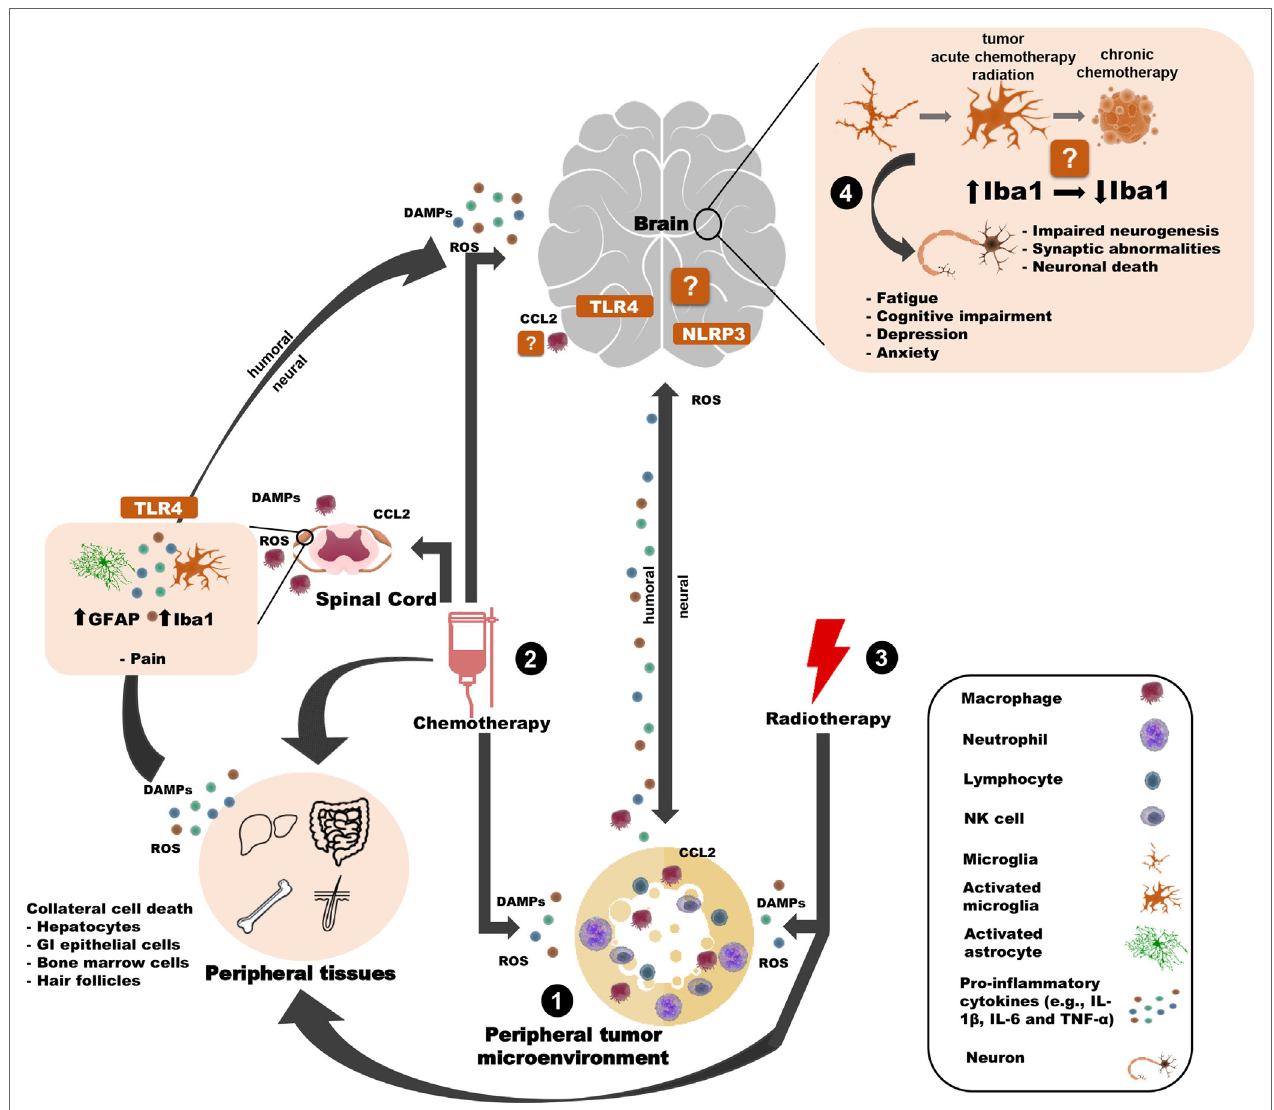
FiGURe 1 | Potential innate immune mechanisms by which peripheral cancer and cancer treatments can induce behavioral changes. (1) The tumor microenvironment releases pro-inflammatory mediators (e.g, cytokines) that can influence the brain and behavior through humoral or neural routes. (2) Chemotherapy induces cell death of tumor cells and healthy cells (in the brain and the periphery), thereby causing the release of DAMPs, ROS, cytokines, and chemokines and contributing to many side effects. For example, chemotherapy-induced peripheral neuropathy is associated with astroglial and microglial activation in the spinal cord and TLR4 activation in DRG neurons. Similar inflammasome activity may occur in the brain. Chemotherapy may also weaken the blood–brain barrier, allowing peripheral immune cells to traffic into/closer to the brain. (3) Peripheral radiotherapy induces cell death of tumor cells and healthy “bystander” cells and (indirectly) contributes to microglial activation and behavioral deficits. (4) Together, the tumor and cancer treatments influence microglia. Tumors and radiotherapy (indirectly) activate microglia, whereas chemotherapy may affect microglia differently over time. Microglia interface with neurons to affect behavior, potentially through. Certain elements of this work were taken and then adapted from somersault18:24 (Library of Science & Medical Illustrations). To view their site, visit http://www.somersault1824.com/. They are licensed under the Creative Commons Attribution-NonCommercial-ShareAlike 4.0 International License. To view a copy of this license, visit http://creativecommons.org/licenses/by-nc-sa/4.0/ or send a letter to Creative Commons, PO Box 1866, Mountain View, CA 94042,